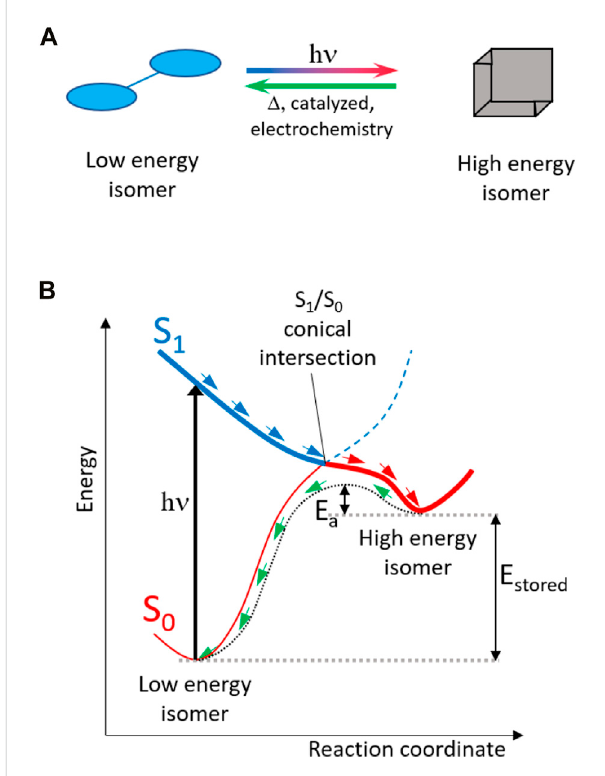
FIGURE 1 Functioning concept of a molecular solar thermal (MOST) system: (A) solar irradiation (h ν ) can convert a low-energy isomer into a stable high-energy isomer. (B) The stored energy (E stored ) can be released on demand by overcoming the ground-state activation energy (E a ) by applying heat, a proper catalyst, or